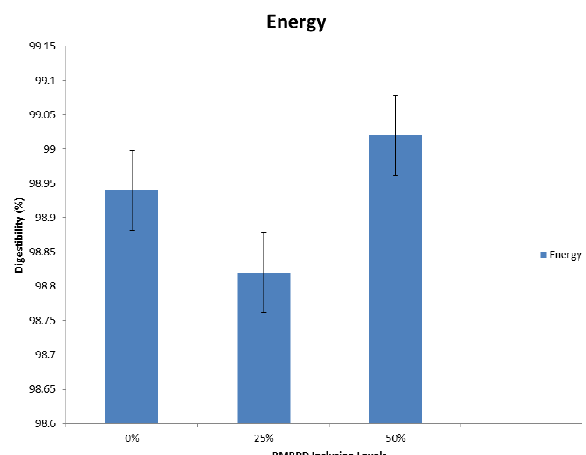
Fig. 3. Energy digestibility in C. gariepinus juveniles fed the experimental